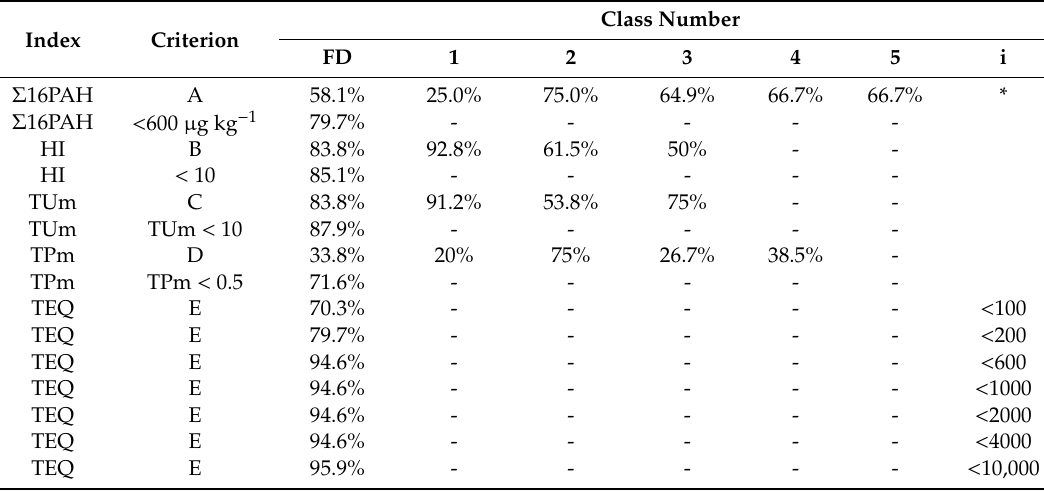
Table 6. Results of indexes prediction with PLS